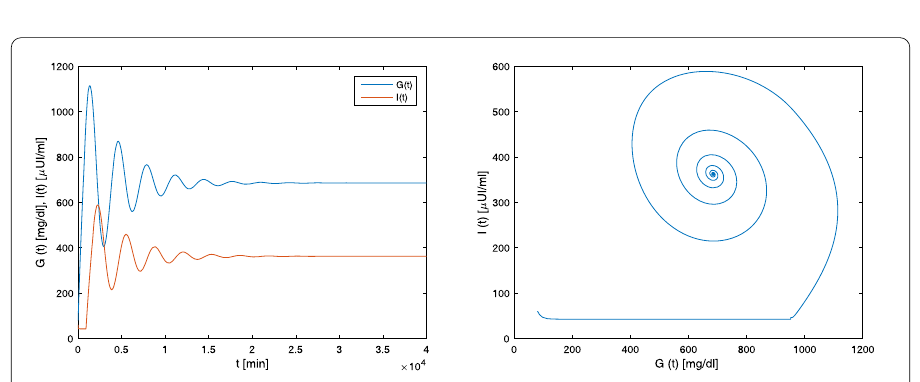
Figure 5 Time series and phase portrait of fractional-order model (29) generated using the information from Set 3, the parameter values in Eq. (58), and τ = 900 < τ 0 = 1285.91. The positive equilibrium ( G ∗ , I ∗ ) = (686.41,362.92) of the system is asymptotically stable